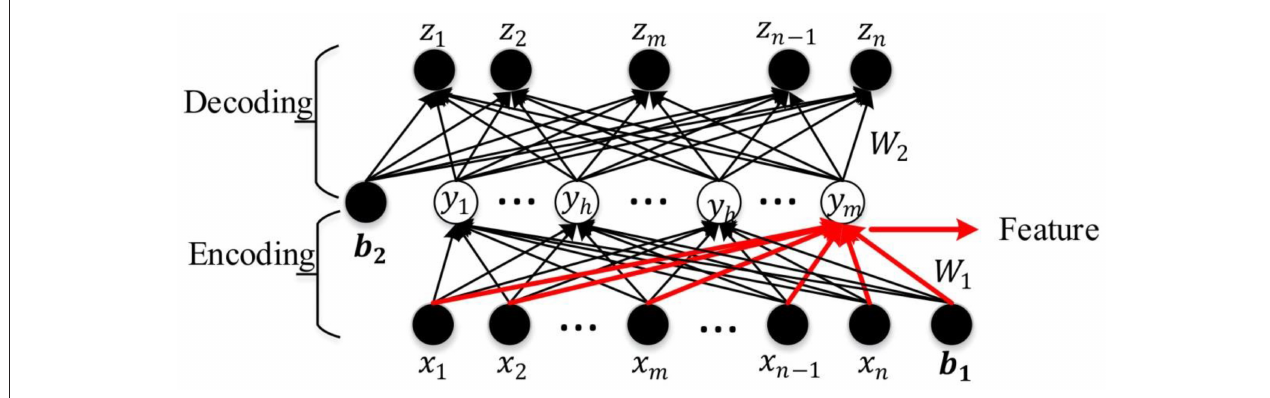
FIGURE 3 | The schematic structure of the